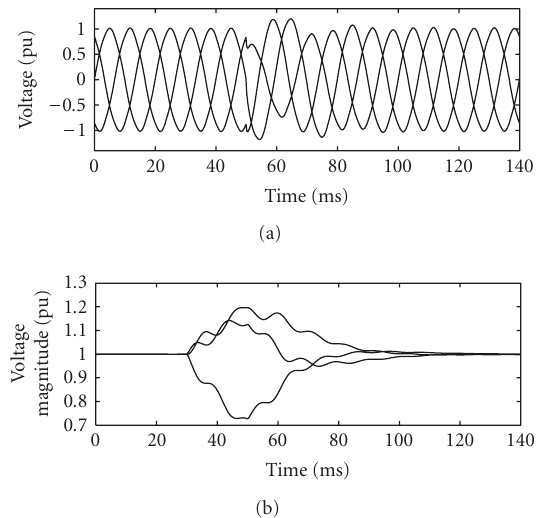
Figure 8: Voltage dip due to a symmetrical fault: (a) voltage wave- forms; (b) voltage magnitude (measurement in an 11 kV network).